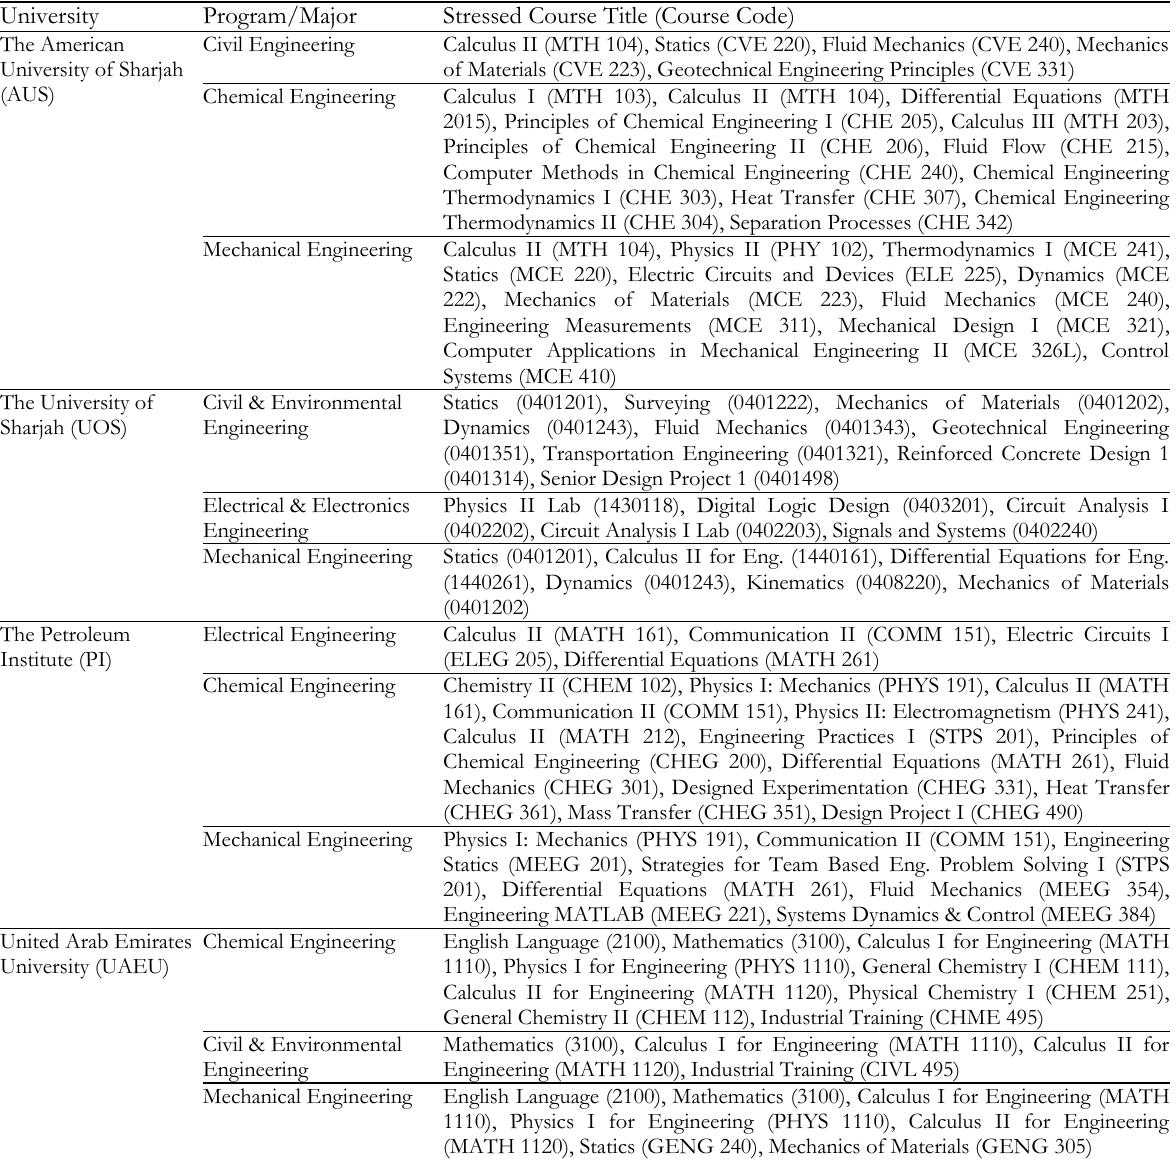
Table 5. Courses that require relaxation of strong pre-and-co-requisite ties in the studied engineering curricula ( NRI <